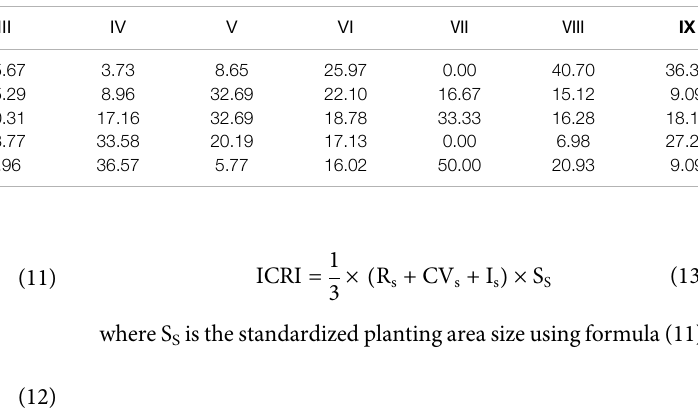
TABLE 3 | Percentage of counties at each level of I R to total counties in corresponding main agricultural